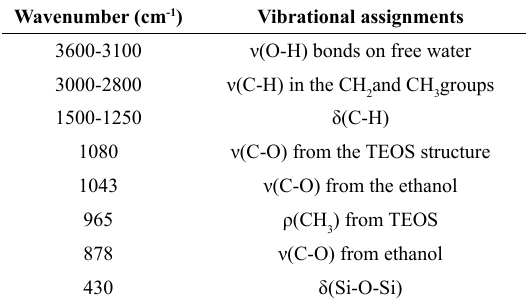
Table 2. Assignments of absorption frequencies of FTIR spectra of silica sol 40 . The symbols are attributed to stretching (ν), bending (δ) and rocking vibration (ρ).